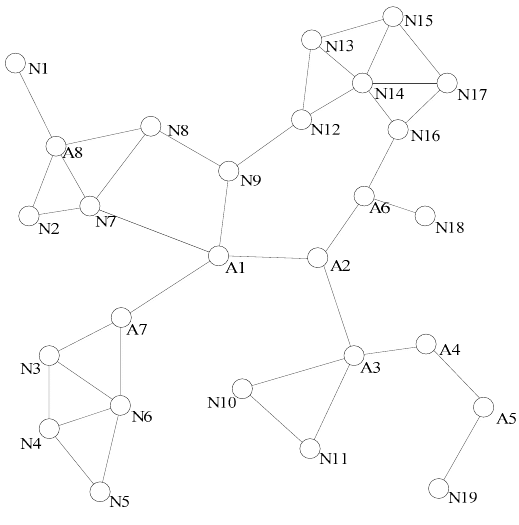
Figure 1. The topological diagram of a normal sensor-actor network.